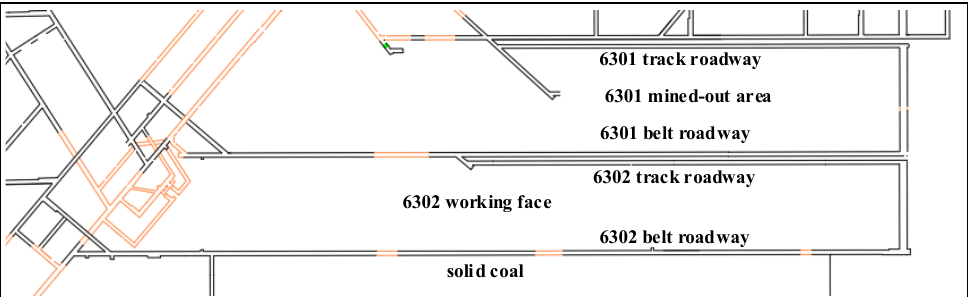
Figure 1. 6302 working face layout diagram.